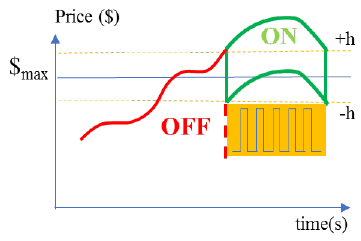
Figure 12. Price evolution, connection and